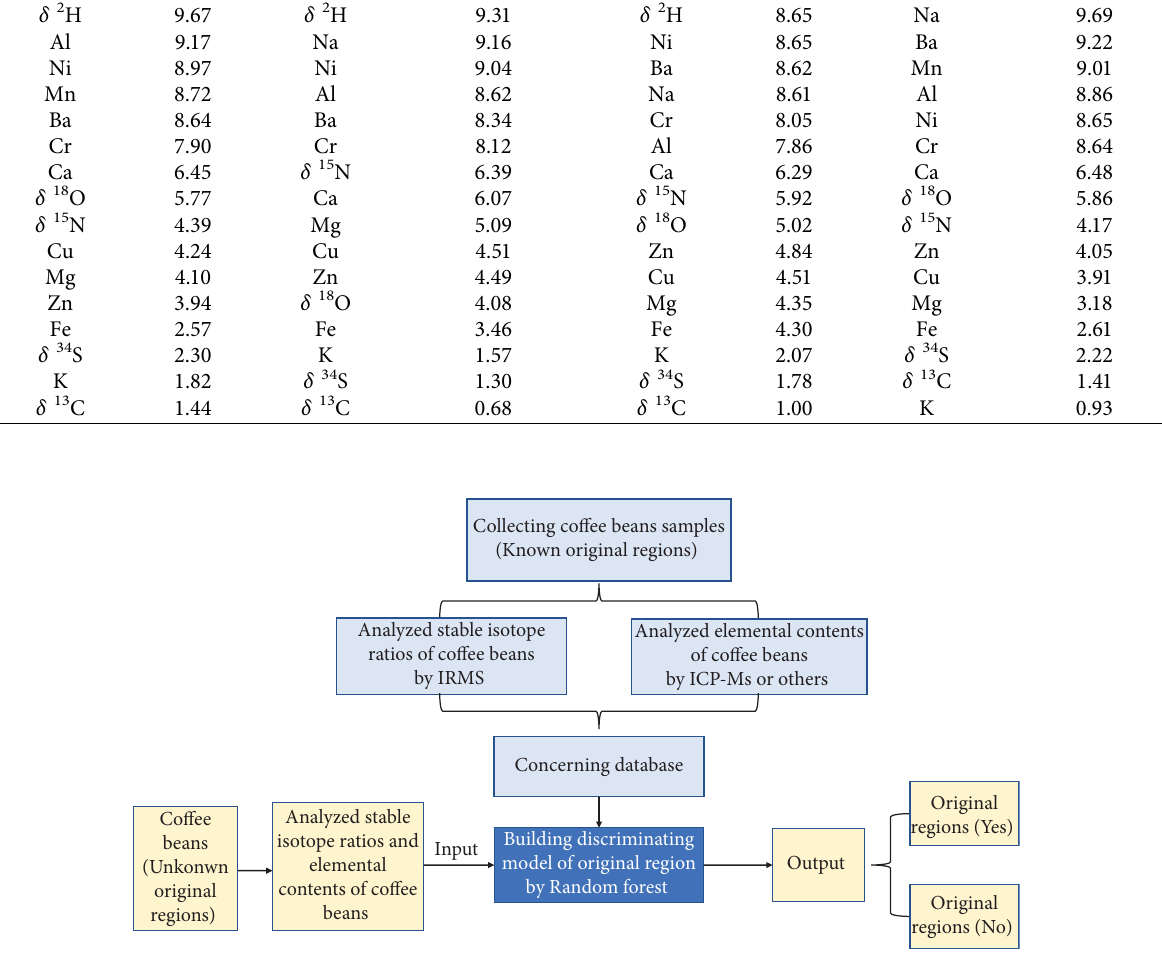
Figure 3: Flow chart of tracing geographical origin of cofee